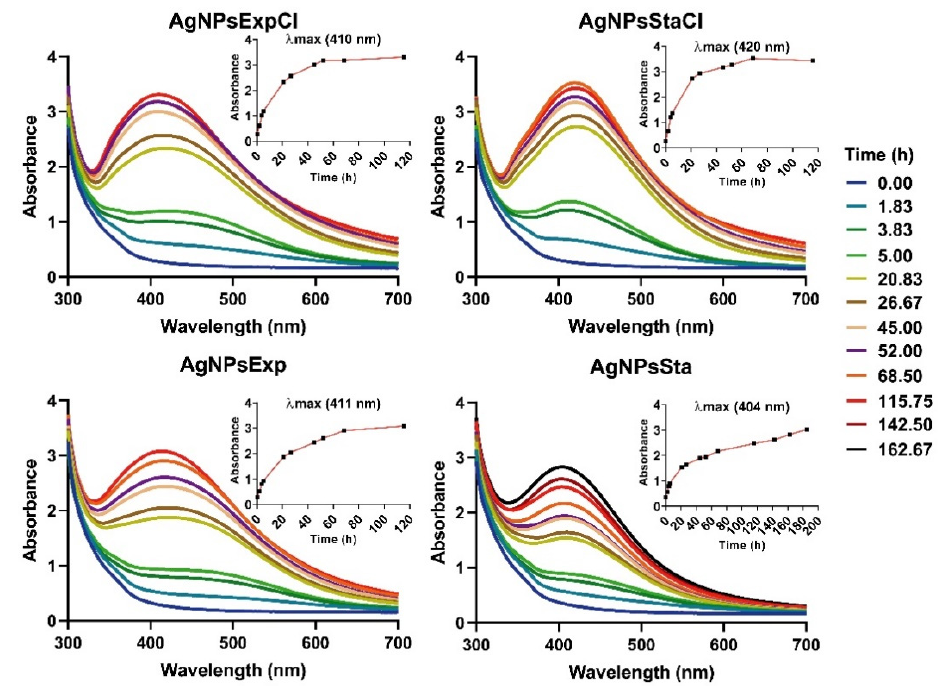
Figure 2. UV-Vis spectra of AgNPs over time during their synthesis. The inset figures in the upper right corner of each panel show the kinetics of synthesis from the increase in absorbance at the corresponding λ max .